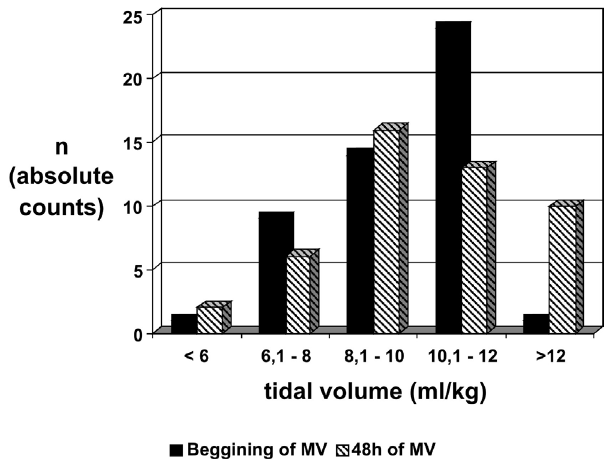
Figure 1 - Exhaled tidal volumes used (ml/kg) in children submitted for 24 hours of MV or more in a reference Brazilian PICU, from October 01 st , 2005 to March 31 st , 2006